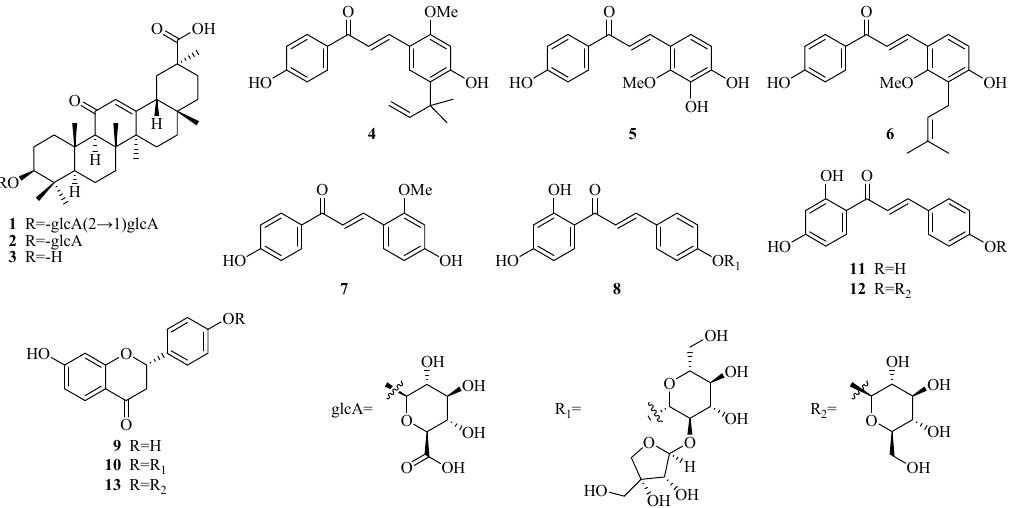
Figure 1. The structures of compounds 1 – 10 isolated from Glycyrrhizae radix et rhizoma and three related compounds 11 – 13 .